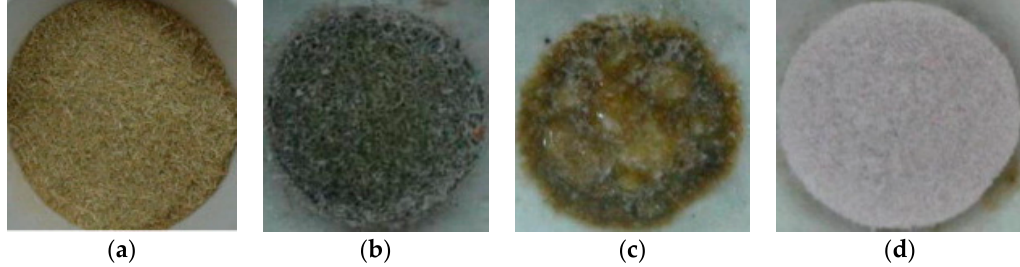
Figure 3. Rice straw: ( a ) before combustion; ( b ) untreated RS combusted at 700–800 ◦ C; ( c ) untreated RS combusted at 900–1000 ◦ C; ( d ) washed RS combusted at 900–1000 ◦ C [198]. Reprinted from Waste